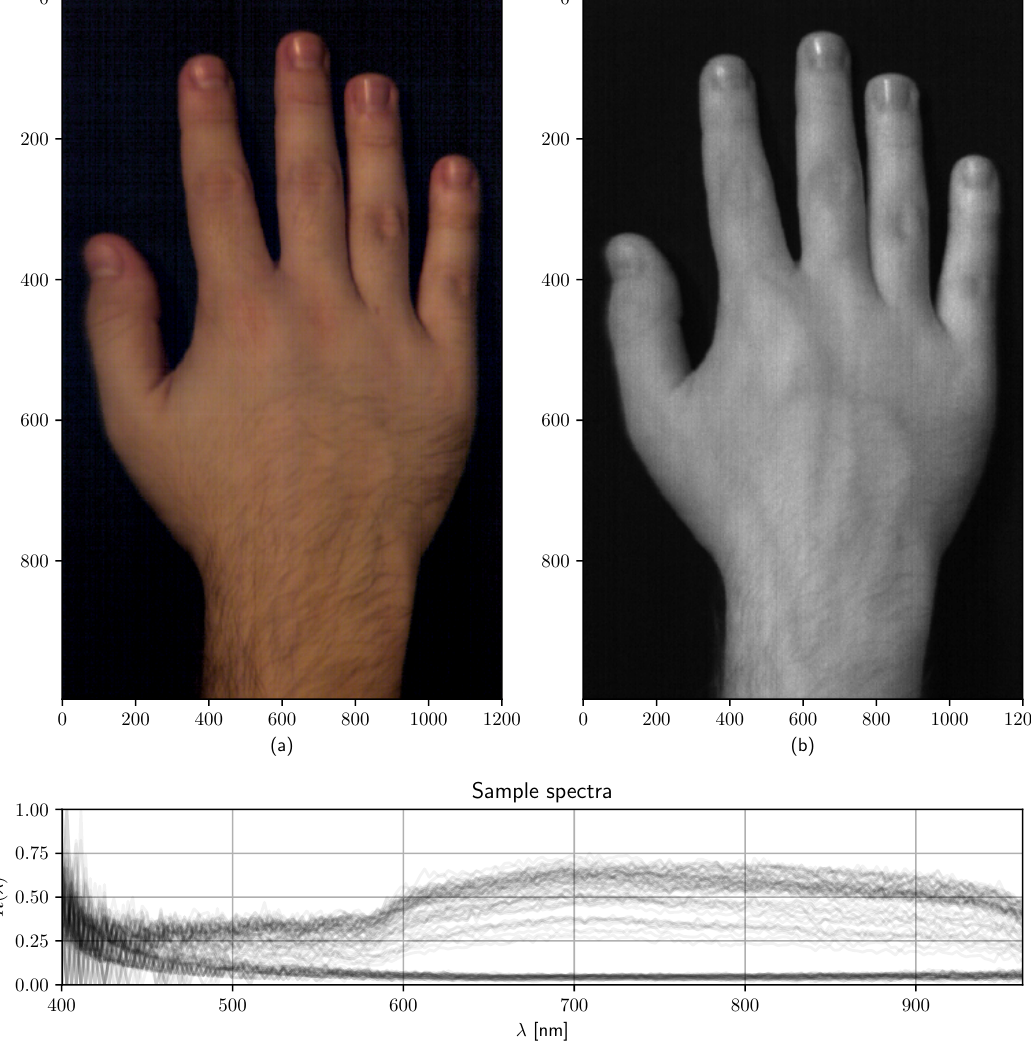
Figure 14. HSI system performance example. Top row: ( a ) RGB color reconstruction of a captured hand over the complete VISNIR range (400–1000 nm). ( b ) 803 nm channel image. Bottom row: 100 overlaid random spectra with 1/100 transparency, showing common spectral